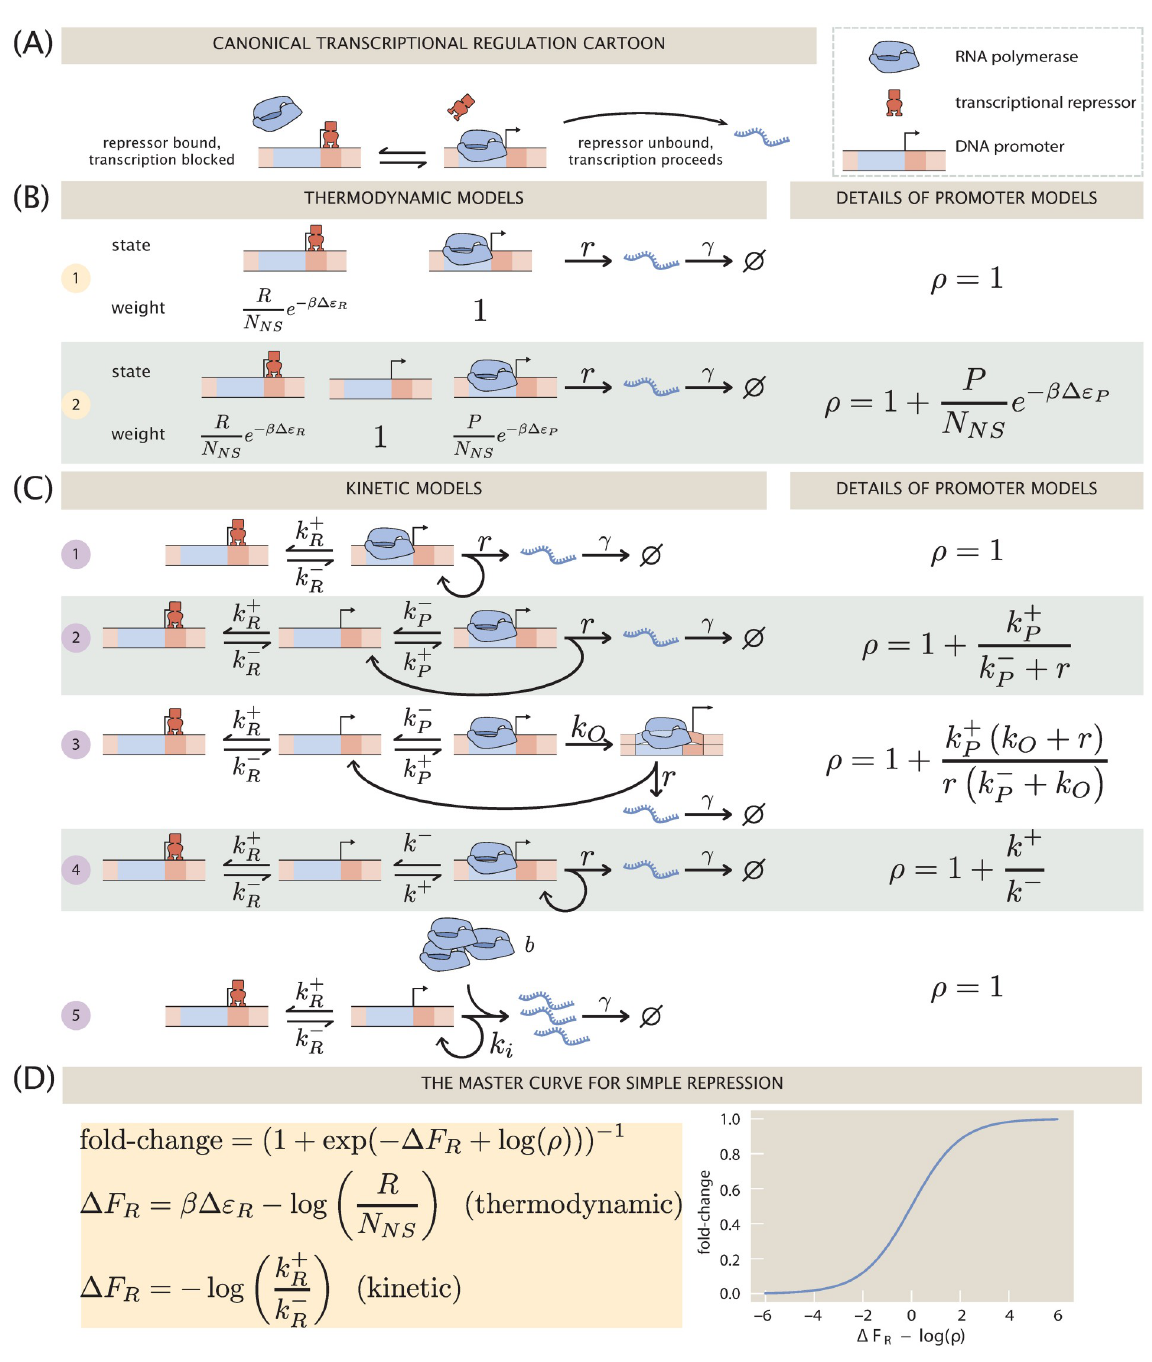
Fig 1. An overview of the simple repression motif at the level of means. (A) Schematic of the qualitative biological picture of the simple repression genetic architecture. (B) and (C) A variety of possible mathematicized cartoons of simple repression, along with the effective parameter ρ which subsumes all regulatory details of the architecture that do not directly involve the repressor. (B) Simple repression models from a thermodynamic perspective. (C) Equivalent models cast in chemical kinetics language. (D) The “master curve” to which all cartoons in (B) and (C)